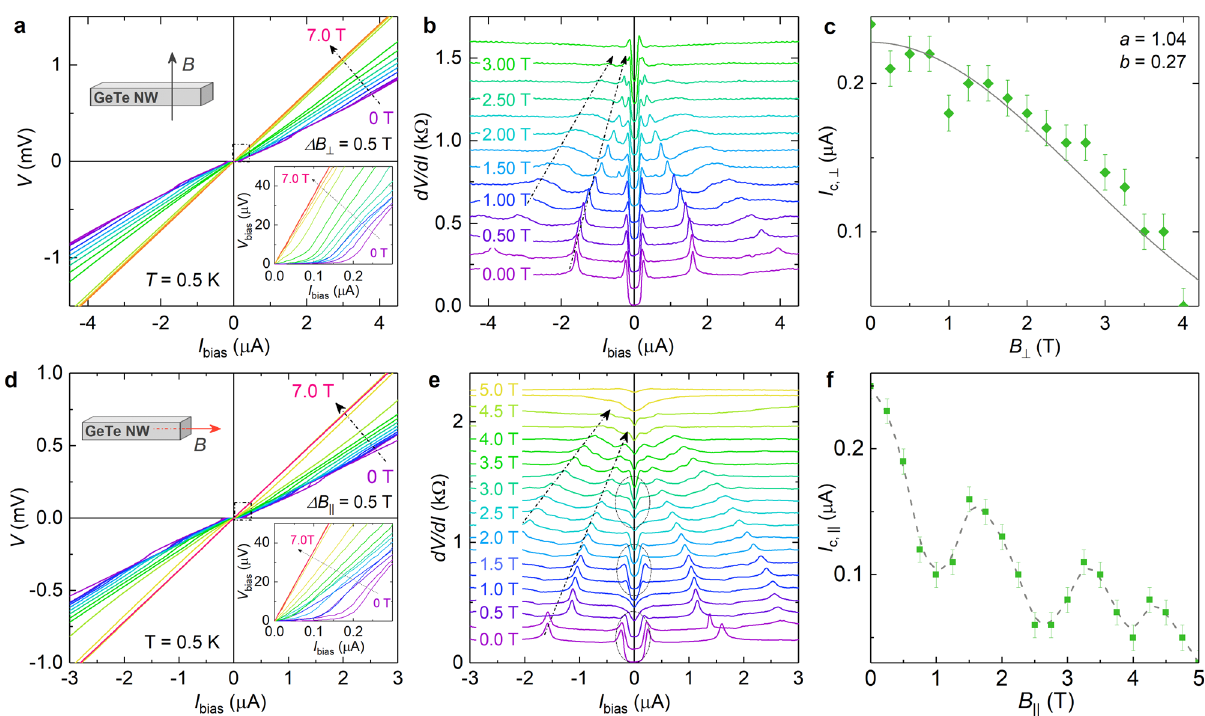
Fig. 4 Magnetotransport transport in Nb/GeTe-nanowire/Nb junction. a I – V characteristics and b the corresponding d V /d I traces of a Nb/GeTe-NW/Nb junction as a function of bias current at 0.5 K by applying various perpendicular magnetic fi elds B ⊥ . The insets in a show the orientation of the magnetic fi eld and a detail at small bias currents. c Experimental (dots) and fi tted (solid line) critical current I c fi eld ( B ⊥ ) based on the , ⊥ as a function of magnetic d V /d I curves at a small bias current region (cf. inset in a ). The error bars represent the resolution of the current bias. d I – V characteristics and e the corresponding d V /d I traces as a function of bias current at 0.5 K by applying various magnetic fi eld parallel to the GeTe NW axis ( B ∣∣ ). The insets in d show a details of the characteristics around zero current bias and illustrate the magnetic fi eld orientation with respect to the nanowire. All d V /d I curves in b and e are shifted vertically for clarity. In e the ranges where a supercurrent is observed are indicated by the ellipses. f Critical current I c, ∣∣ as a function of magnetic fi eld based on the d V /d I . The dashed line is a guide to the